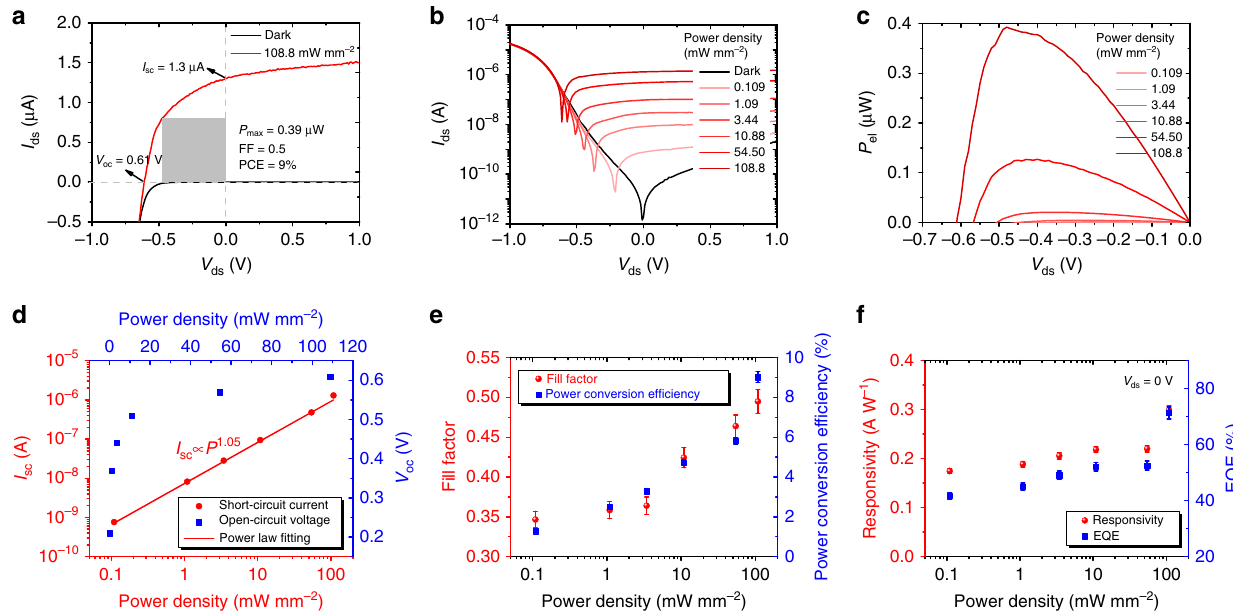
Fig. 4 Photovoltaic response of the MoS 2 /AsP vdWHs diode. a I ds – V ds curves of the MoS 2 /AsP vdWHs diode under dark (black line) and 520 nm laser illumination (red line), respectively. The gray region indicates where the maximum electrical power is obtained. b I ds – V ds curves of the MoS 2 /AsP vdWHs diode under 520 nm laser illumination with different power densities. c Output electrical power P el as a function of V ds . d Power dependent short-circuit current I sc and open-circuit voltage V oc . e Power dependent fi ll factor (FF) and power conversion ef fi ciency (PCE). f Power dependent responsivity and external quantum ef fi ciency (EQE). Error bars represent standard